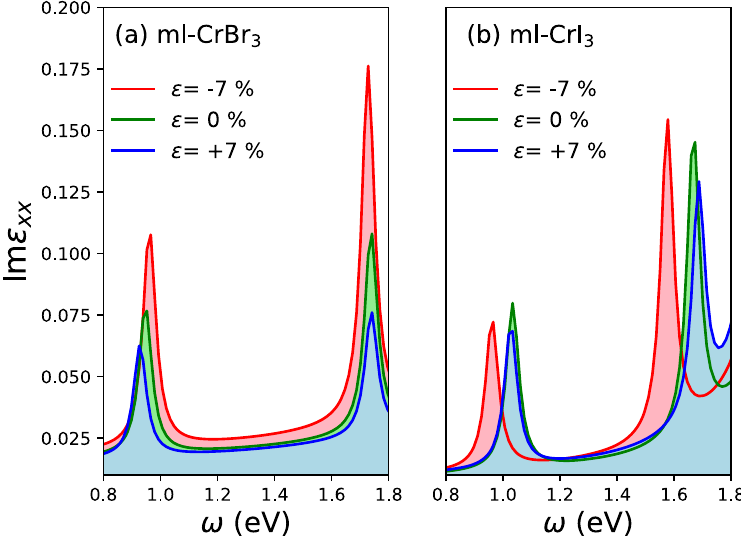
Fig. 8 Tunability of excitons in monolayer CrBr 3 , CrI 3 under strain. Volume conserving tensile and compressive strains ϵ are applied. E ex does not change for X = Br, while it changes by 100 meV for compressive strain of ϵ = 7% in X = I. Intensities of the peaks are multiplied by a constant factor of three in ml-CrBr 3 to bring them to the same scale as ml-CrI 3 .